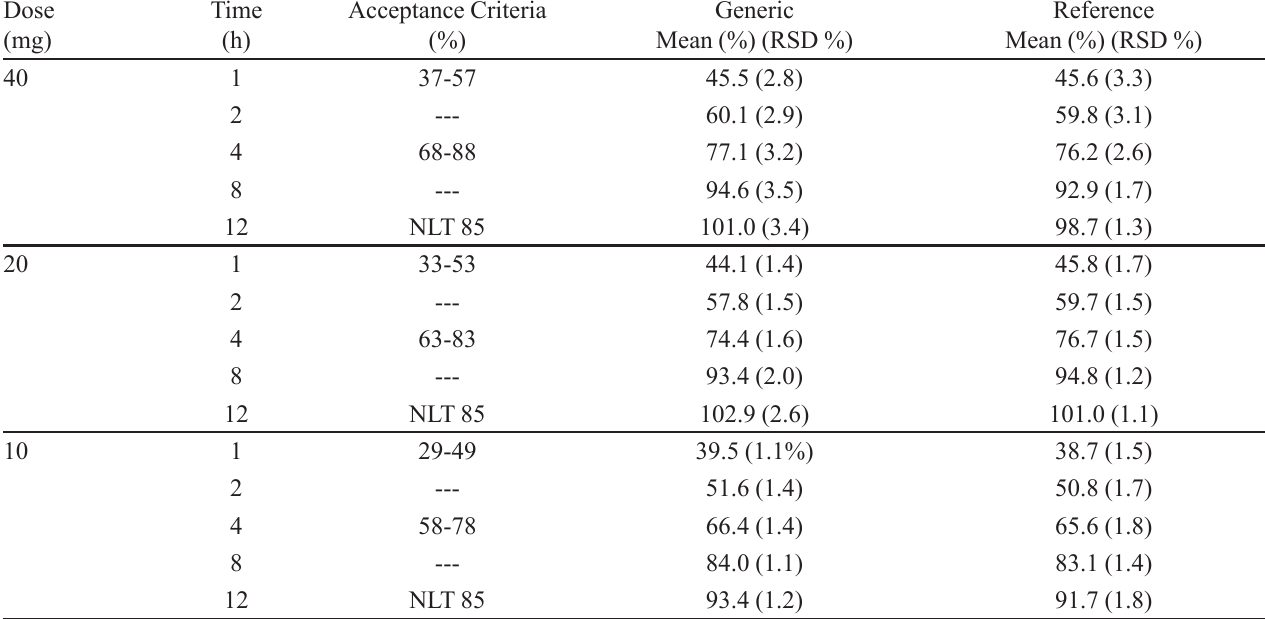
TABLE I - Dissolution results of oxycodone extended-release tablets Dose